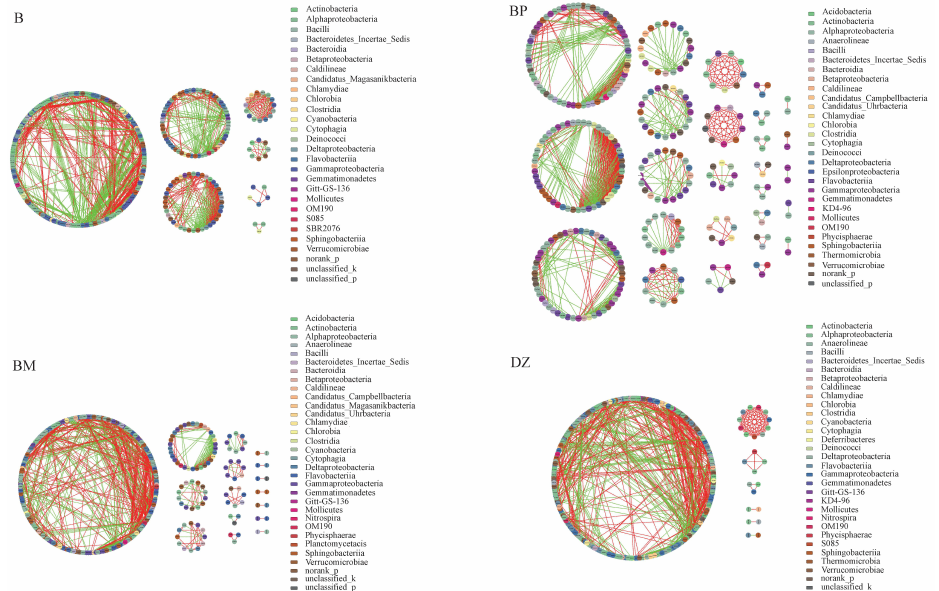
Figure 9. Ecological Network based on OTUs of the bacterial community in the different culture systems. Note: In the ecological network diagram, different nodes represent bacteria from different OTUs, and the line between two nodes indicates that there is some interaction between bacteria from two OTUs, and the red line represents a positive relationship between bacteria from two OTUs, the green line represents a negative relationship. The group B, a single B. pumilus BP-171 was added; the group BP, B. pumilus BP-171, and PHBV were added; the group BM, B. pumilus BP-171, and molasses were added; the group DZ, the control without any probiotics and carbon sources